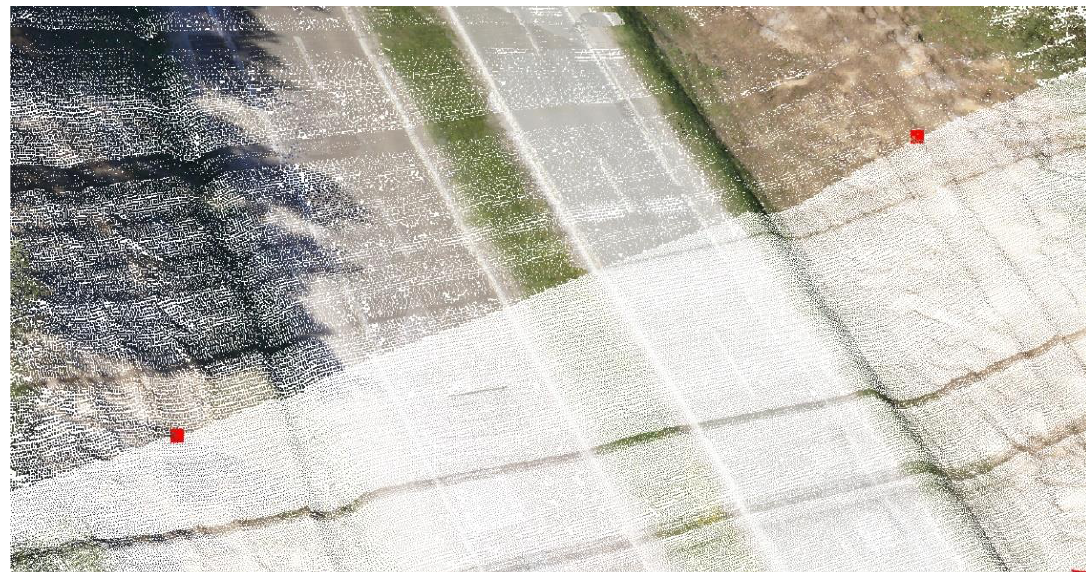
Figure 11. A correct joint of segments of the highway test case with ref GCPs. The joint is seen thanks to different cloud point sizes.